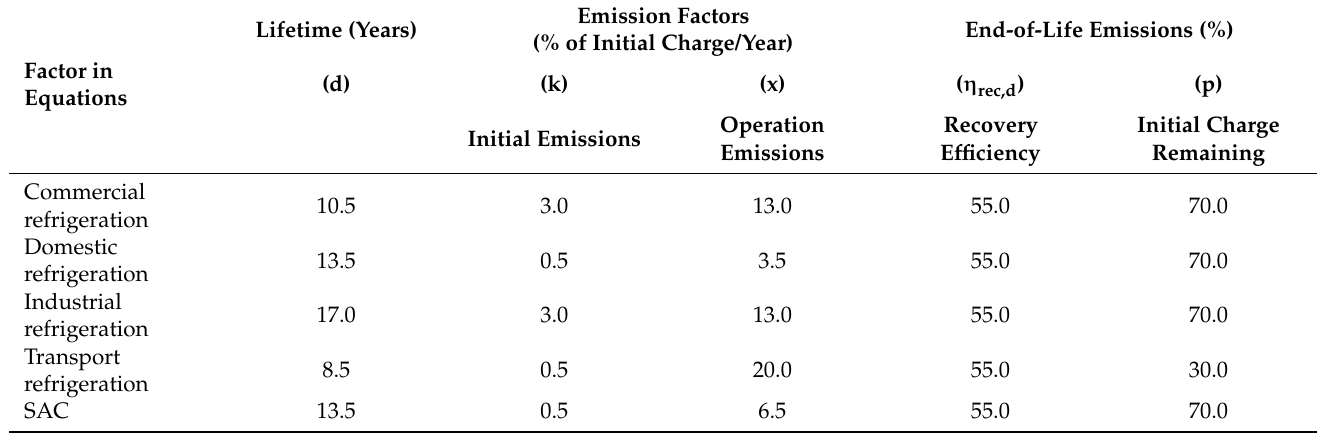
Table 3. EFs used for emission estimation for the years